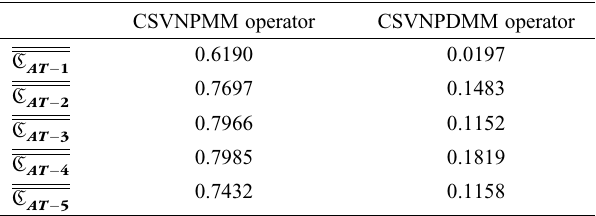
Expression of the sensitive analysis for the data in Table 1